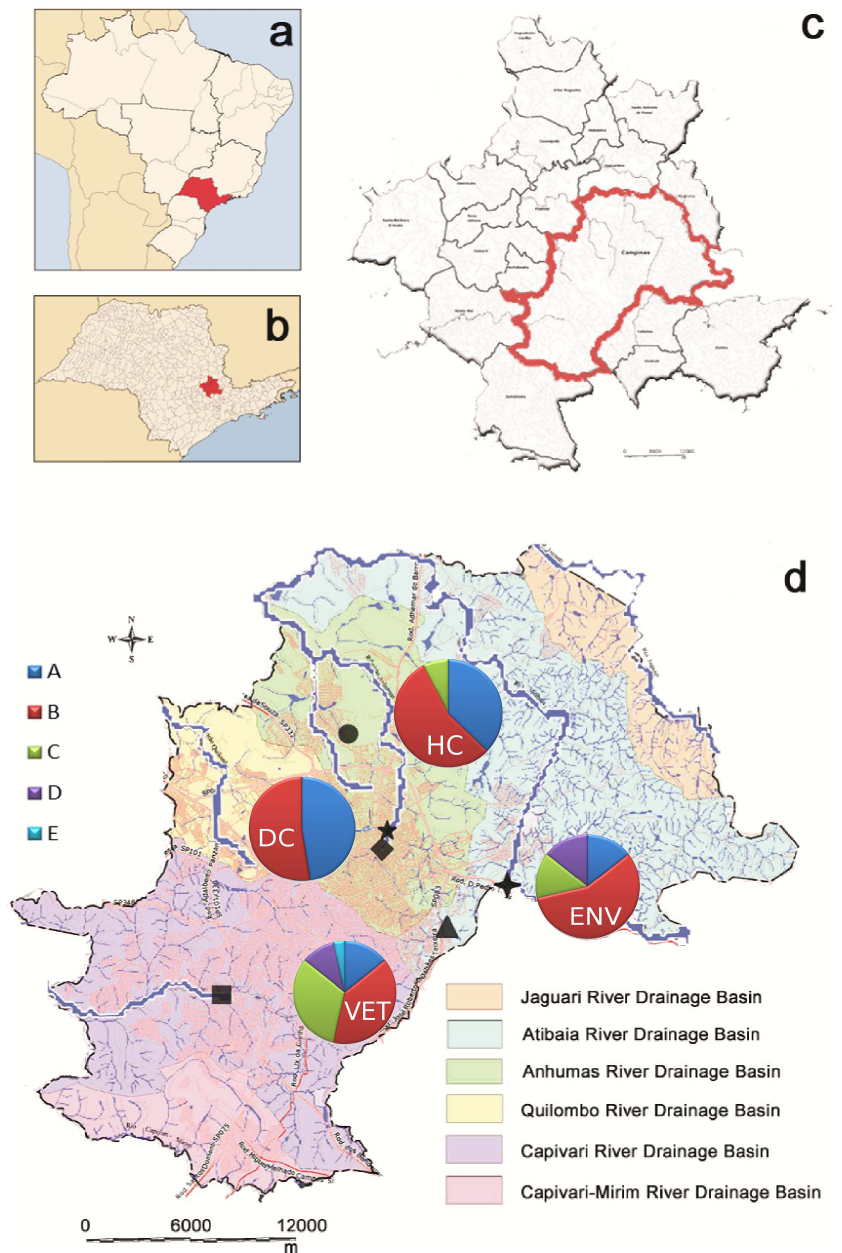
Fig. 1. Collection sites of positive samples. Brazil (a), state of Sa˜o Paulo (b), metropolitan region of Campinas (c) and the collection sites of positive samples plotted on a map of the city of Campinas colored to N indicate the various drainage basins (d). The assemblages identified in each group were plotted in the map Unicamp Hospital and hospital sewage. X Proenc¸a stream, Serafim stream and close to the collection site. w Anhumas River. m Samambaia day-care center. & Ouro Verde Hospital. X Campinas water abstraction site. waste water treatment plant.